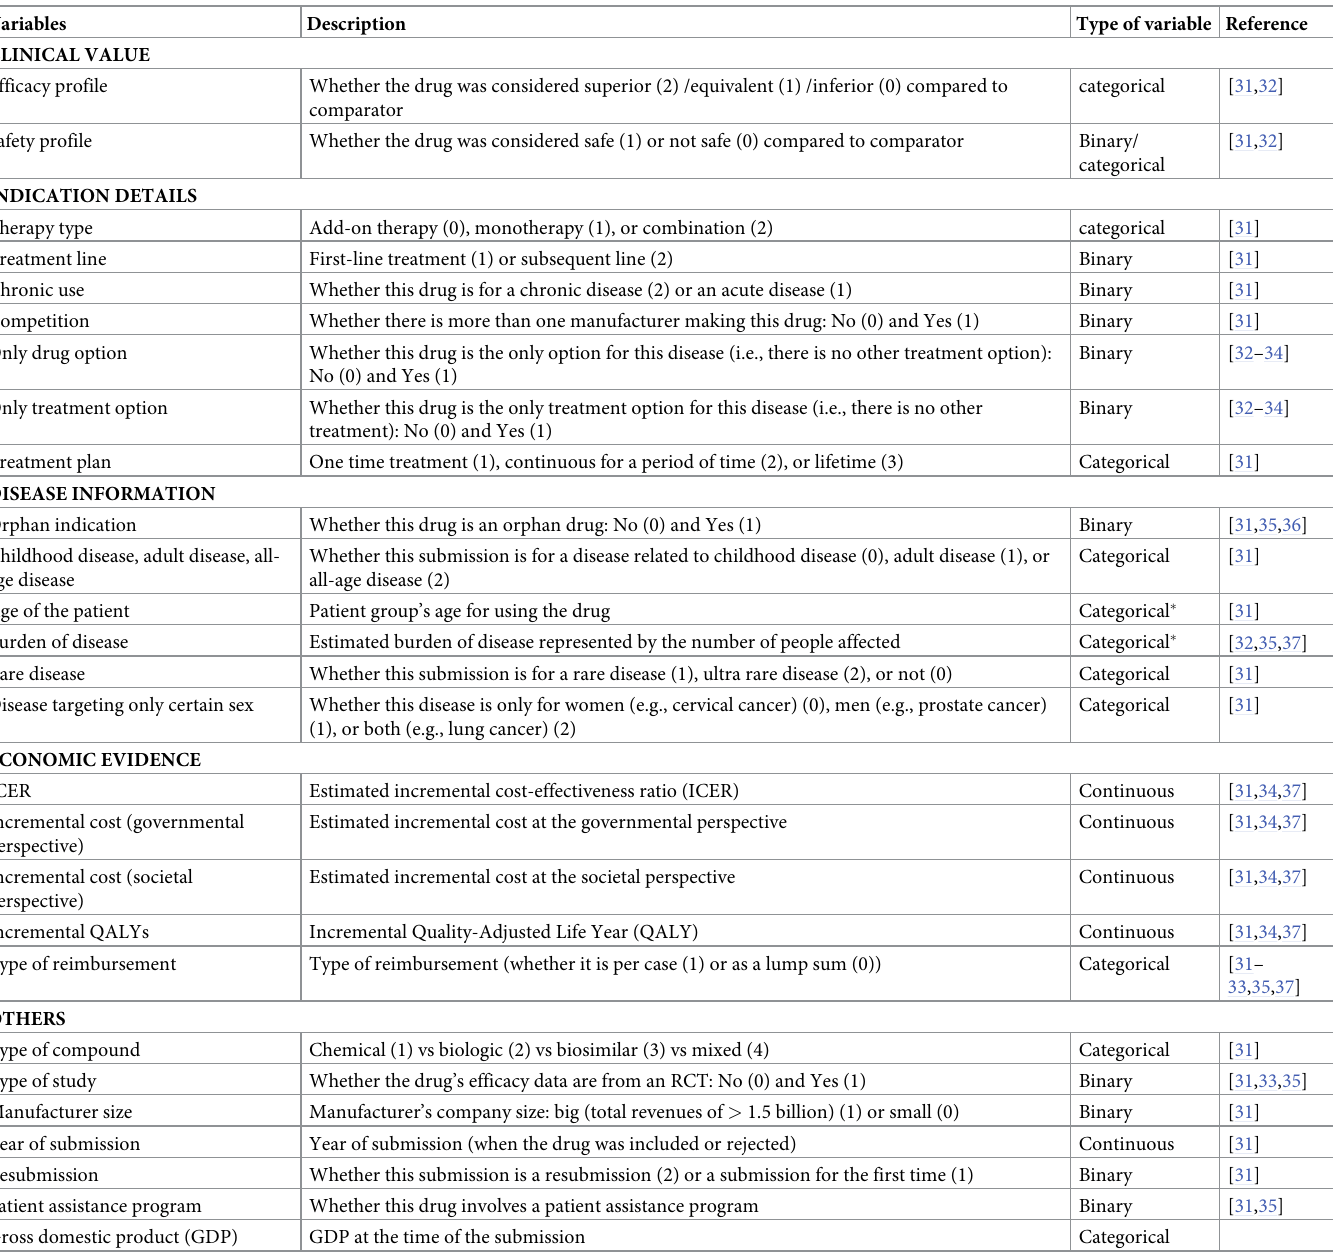
Table 1. Summary of confounders which may associate with price, decision, and